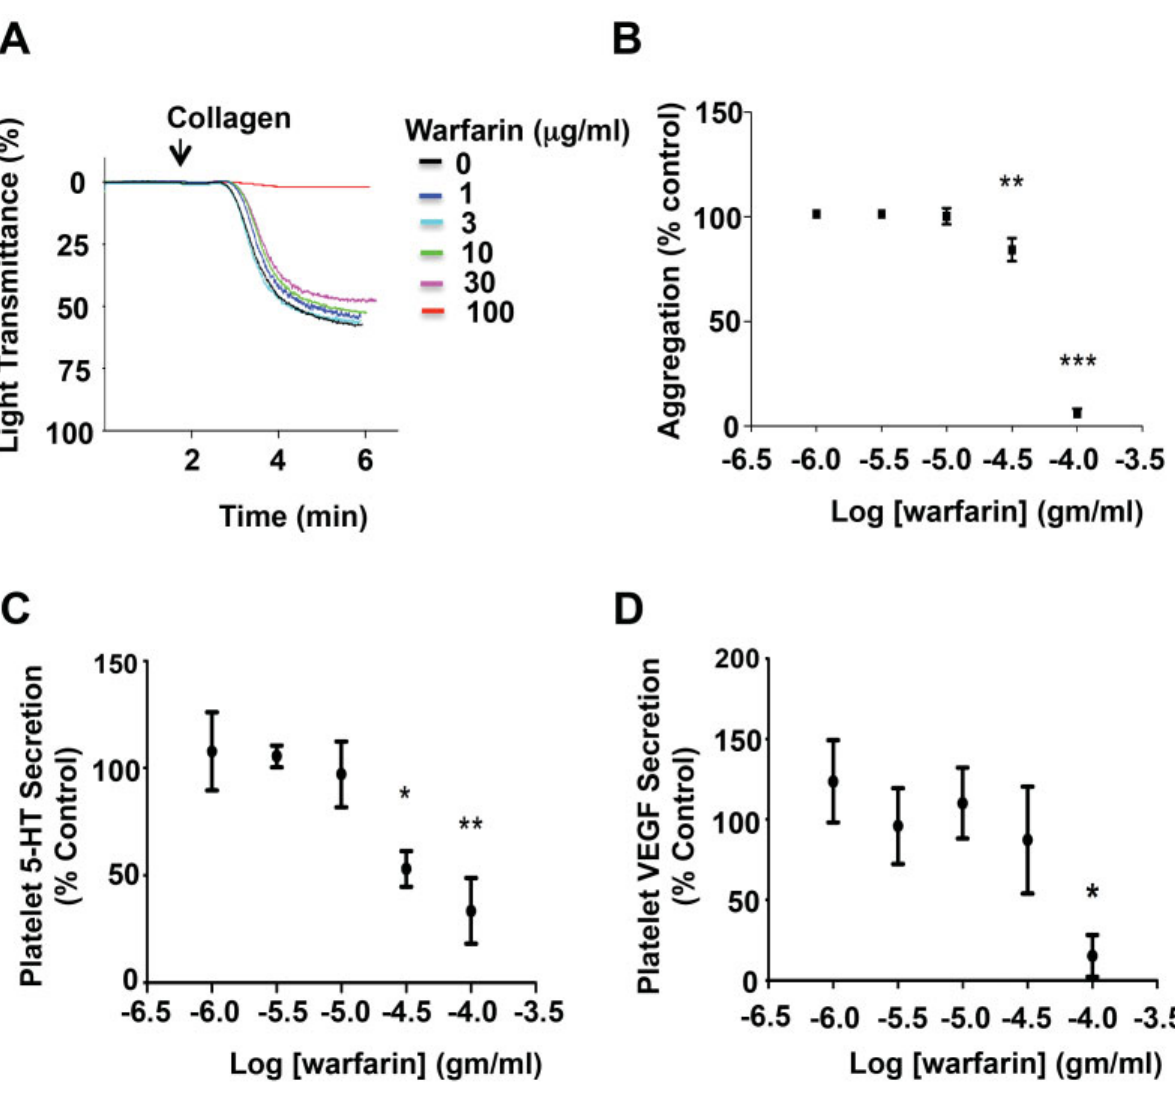
Fig.1 ( A ) Representative platelet aggregometry traces and ( B ) summary data demonstrating the concentration-dependent inhibitory effects of warfarin on platelet aggregation. N ¼ 5 (3 female donors and 2 male donors). (cid:1)(cid:1) p < 0.01; (cid:1)(cid:1)(cid:1) p < 0.001. ( C, D ) Summary data demonstrating the inhibitory effects of warfarin on platelet 5-HT and VEGF secretion, respectively. N ¼ 5 (3 female donors and 2 male donors). (cid:1) p < 0.05; (cid:1)(cid:1) p < 0.01. VEGF, vascular endothelial growth factor; 5-HT,